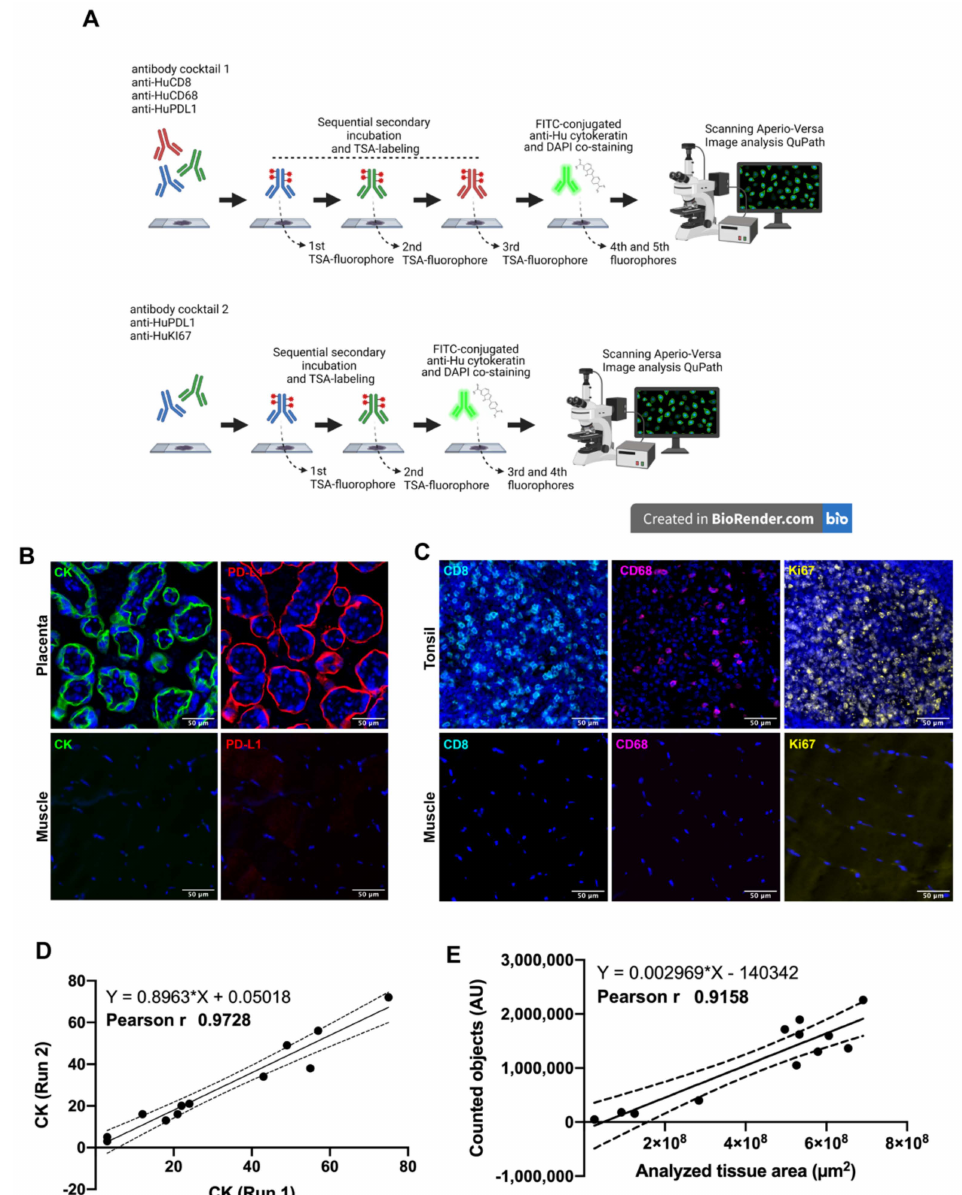
Figure 1. Multiplex Immunofluorescence workflow. In ( A ) after antigen retrieval, each whole tissue slide was incubated with the indicated antibody panel. Sequential signal detection required isotype- specific HRP-conjugated antibodies, tyramide-based fluorophores and digitalization using Aperio VERSA 200 microscope (designed using Biorender). In ( B , C ), the staining pattern for positive control tissues are shown. Images are representative for cytokeratin (CK) and PD-L1 in human placenta ( B ). Immune markers CD8 and CD68, and proliferation as Ki67 were verified in human tonsil ( C ). Skeletal muscle was used as negative control. Correlation between two independent staining runs is shown for CK ( D ) as well for the correlation between the scanned area and counted objects ( E ). Scale bar represents 50 µ m. Nuclei were stained with